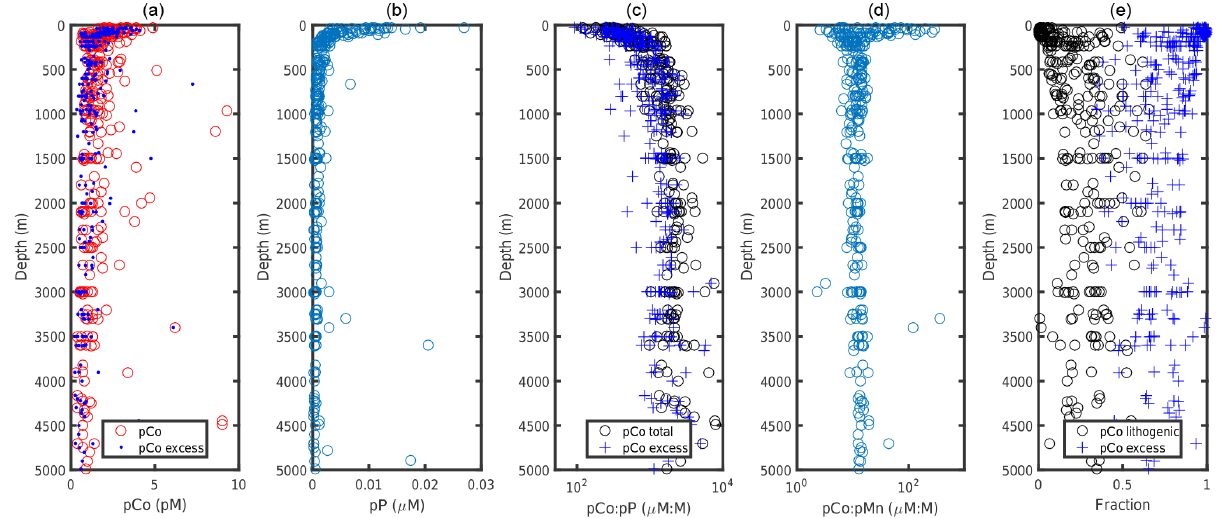
Figure 11. Full depth distributions of (a) particulate cobalt ( p Co), (b) phosphorus ( p P), (c) ratios of p Co: p P (inset 0–500m depth), (d) ratios of p Co and particulate manganese ( p Co: p Mn), and (e) the fraction of lithogenic and excess cobalt from the North Atlantic zonal GA03 section (McLane pump 0.8–51µm filter samples; data from Ohnemus and Lam,